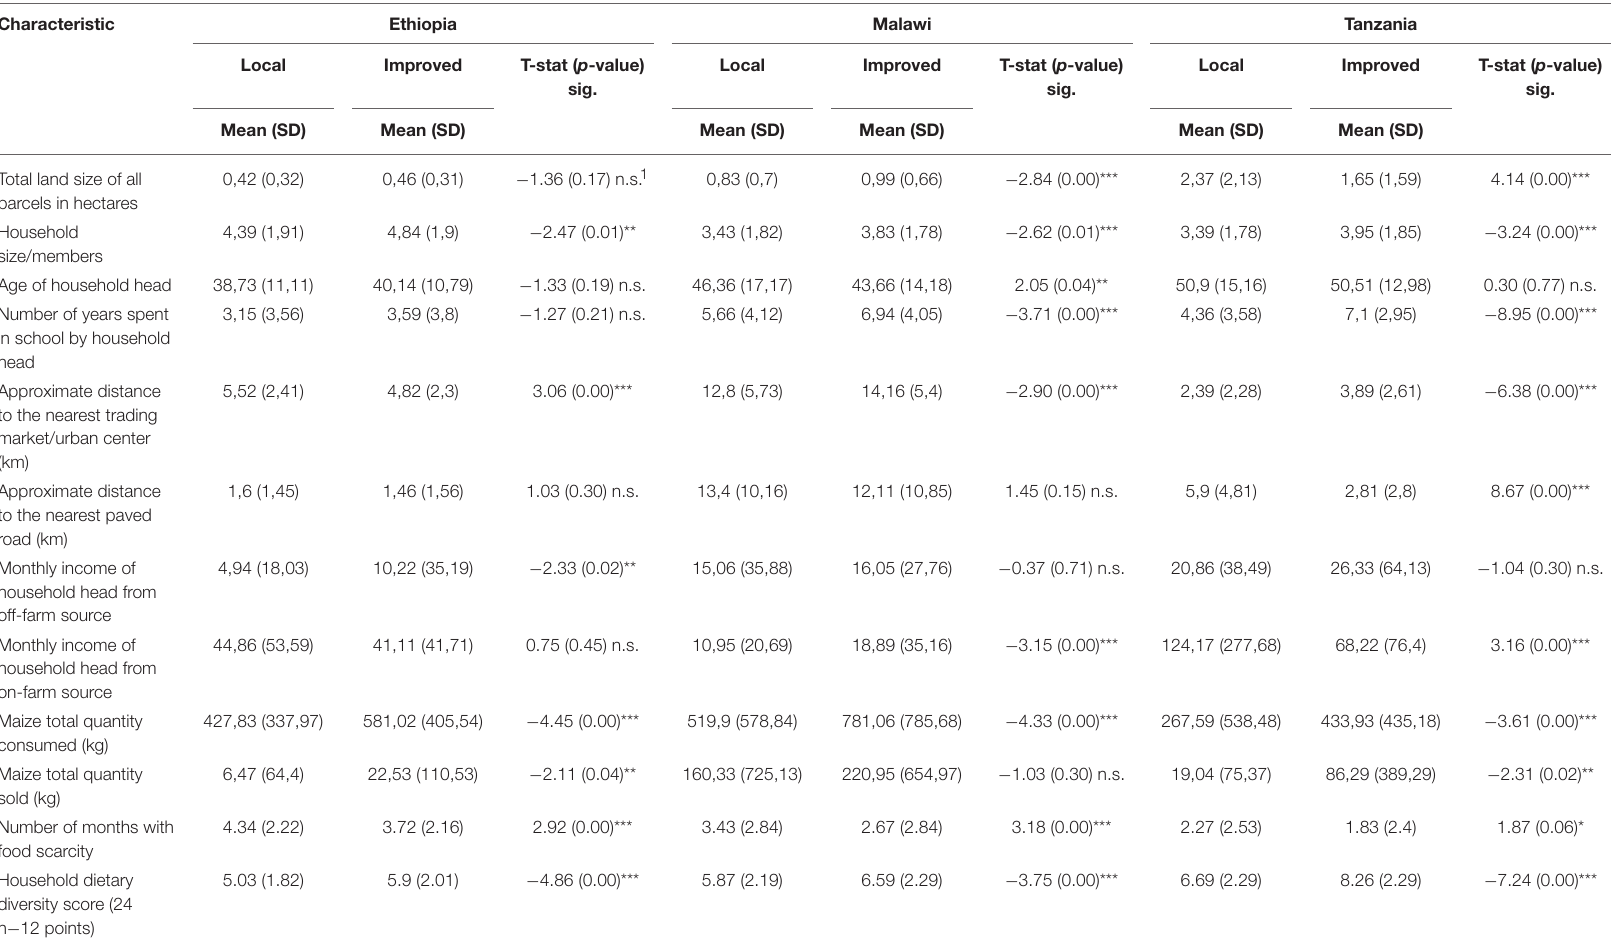
TABLE 3 | Comparison of households growing local and improved varieties of maize. Only households cultivating one of the types are compared and the households cultivating both types (see Table 2 ) are excluded from the analysis ( N = 1,598). Characteristic Ethiopia Malawi Tanzania Local Improved T-stat ( p -value) Local Improved T-stat ( p -value) Local Improved T-stat ( p -value) sig. sig.